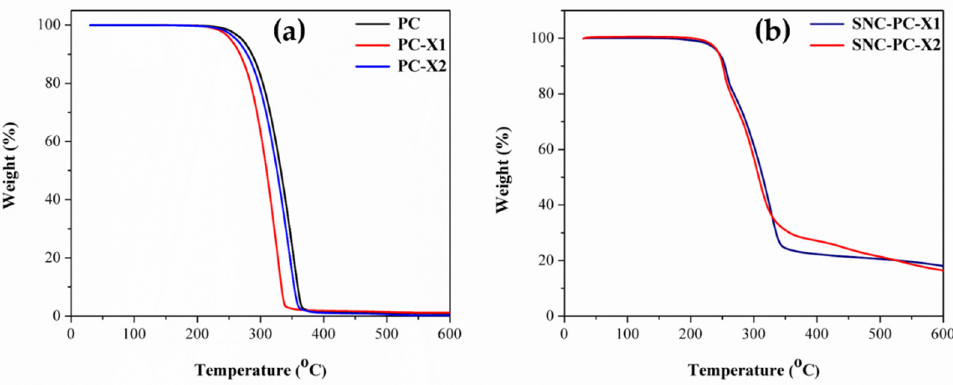
Figure 6. ( a ) TG plot of PC and xerogels (PC-X1 and PC-X2); ( b ) TG plot of xerogel silver nanocomposites (SNC-PC-X1 and SNC-PC-X2), under N 2 gas at a heating rate of 10